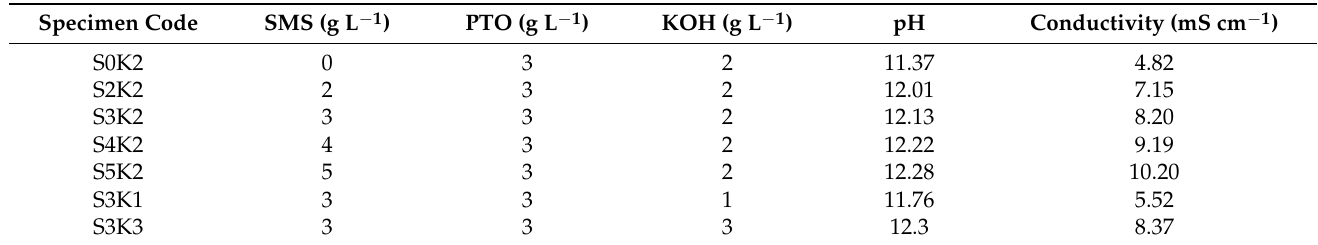
Table 1. Specimens codes, and composition, pH and conductivity of the coating solutions. Specimen